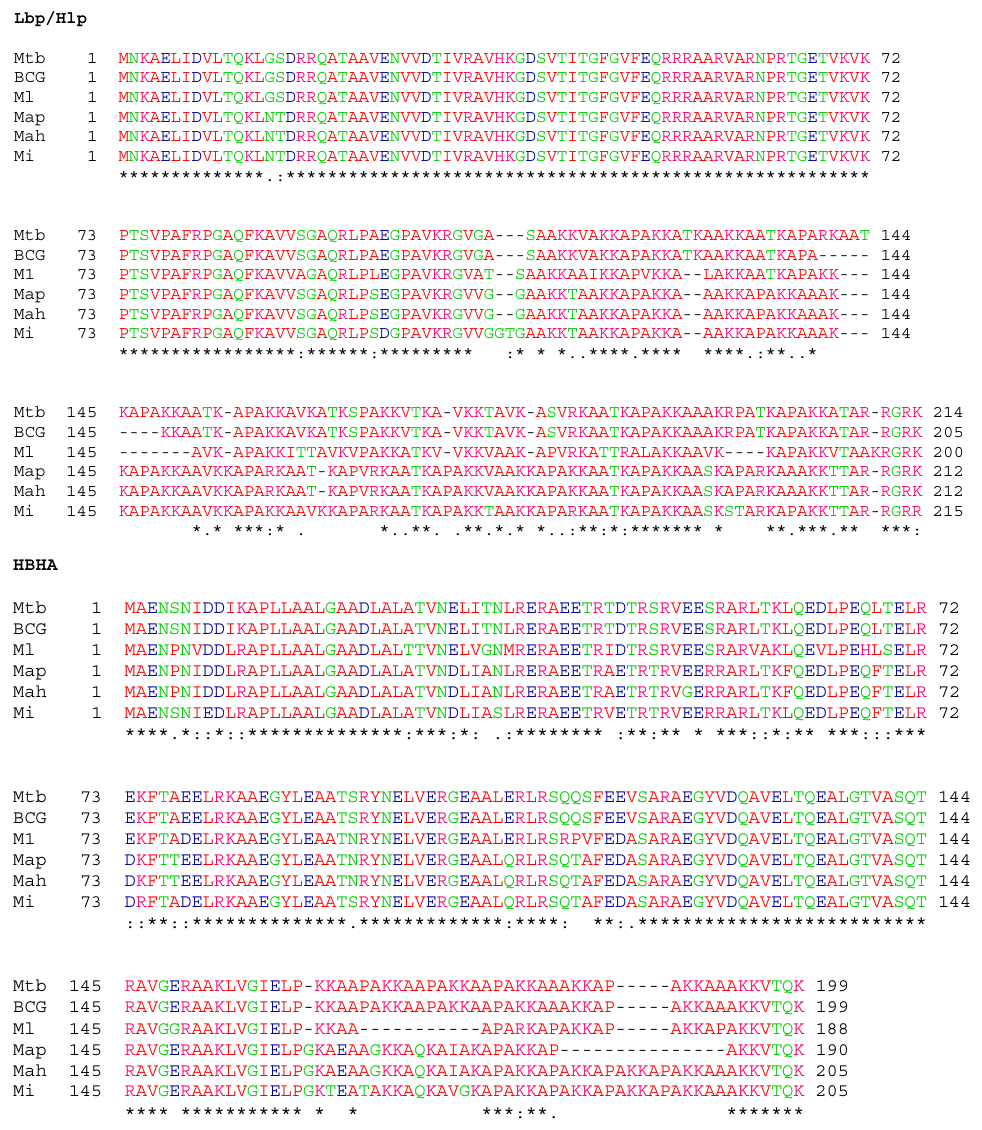
12 of 16 Figure 7. Human serum antibody levels to HBHA and LBP from M. intracellulare . ELISA were performed on plates coated with PPDj, HBHA or LBP purified from M. intracellulare . The panel of sera tested included 6 healthy donors (HD) and the 17 patients included in this study (P). Serum samples were realized in triplicate. Statistical analysis was performed with Tukey’s multiple comparison tests. **, p < 0.005, ***, p = 0.001. 4. Discussion One of the major outcomes of this study is the first characterization of HBHA and LBP of M. intracellulare . Interaction of M. intracellulare with airway epithelial cells can be modulated by heparin or laminin. The addition of exogenous heparin competed with the heparan sulfates present on the proteoglycan components of the cell surface, thereby reducing binding of the bacteria on epithelial cells. Conversely, adding laminin attaches to the bacteria and then binds to its cellular receptor, thereby increasing the adhesion of the bacteria to epithelial cells. Mass spectrometry analysis of heparin-Sepharose-purified M. intracellulare HBHA and LBP revealed the characteristic features of these conserved mycobacterial proteins. The affinity properties of these adhesins to sulfated heparin are comparable to their homologs described in Mycobacterium tuberculosis Complex (MTBC) and Mycobacterium leprae [19,23,41]. These adhesins possess a typical C-terminal domain consisting essentially of lysine/ alanine/proline repeats involved in the interaction with GAGs [23] (Figure 8).